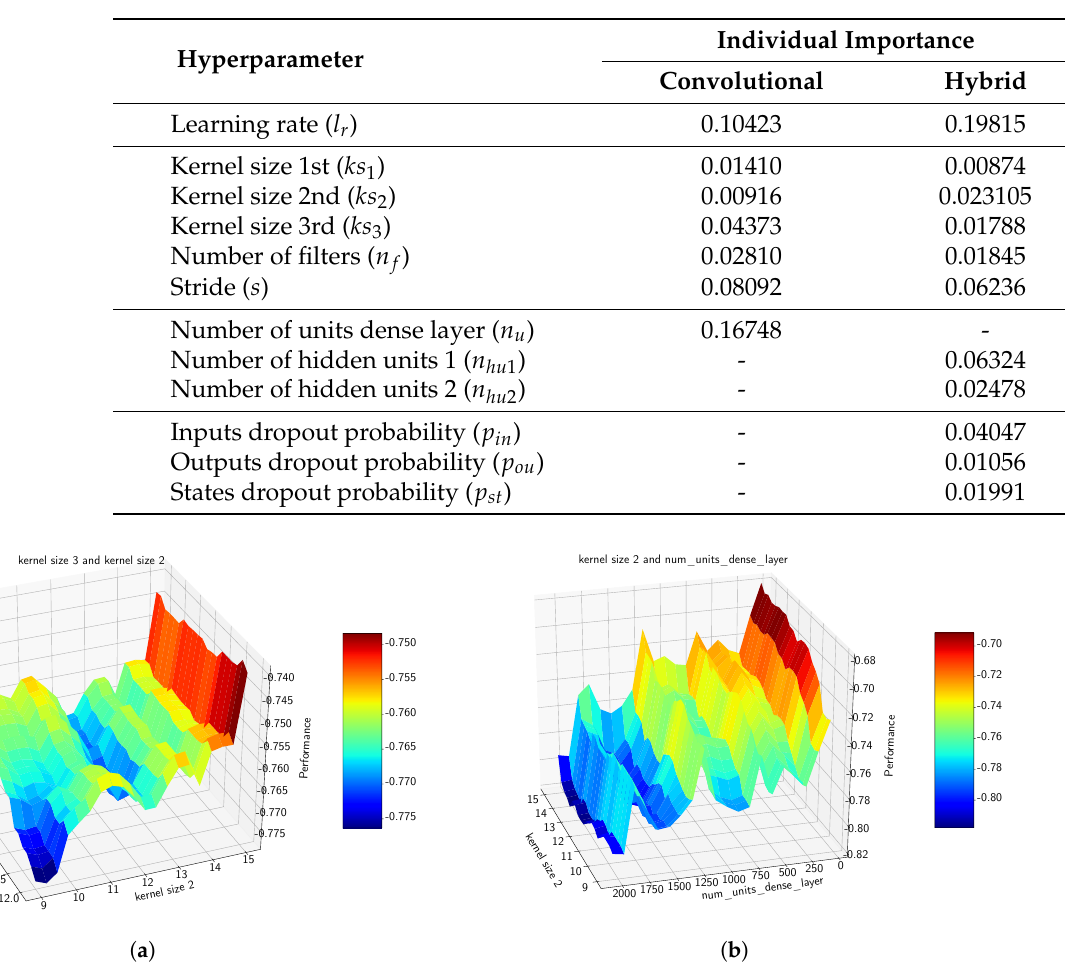
Figure 19. Pairwise marginal plots produced via the fANOVA framework [115]. These plots illustrate the interplay (or the mutual impact influence) between some of the hyperparameters being optimized in ( a ) interplay between kernel sizes 2 ( ks 2 ) and ( ks 3 ) ( b ) interplay between the number of units of the dense layer ( n u ) and kernel size 2 ( ks 2